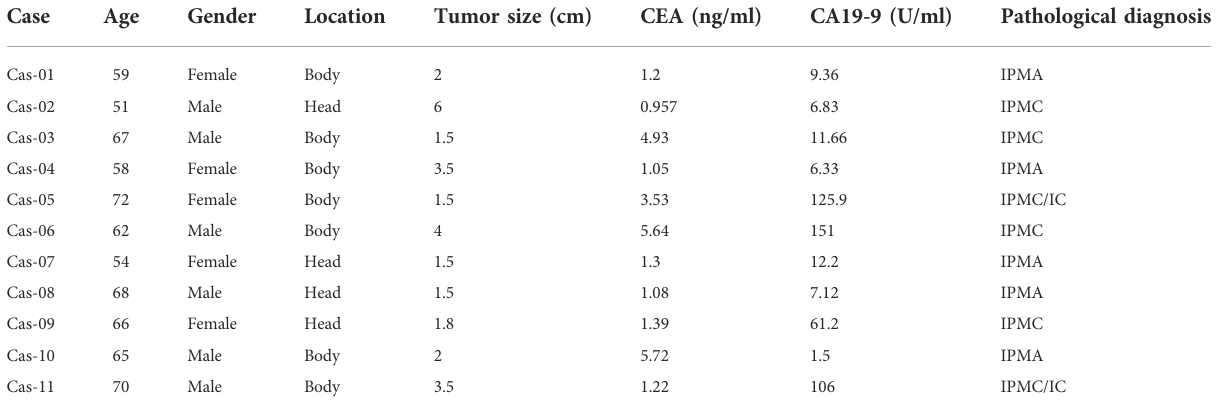
TABLE 1 Clinicopathological data from included analyzed IPMNs in Nanjing medical af fi liated cancer